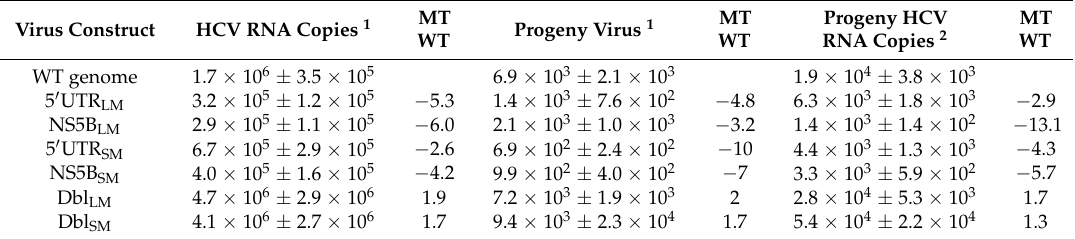
Table 2. HCV RNA levels and progeny virus titers in Huh-7 cells transfected with 5’UTR and NS5B mutant genome constructs.